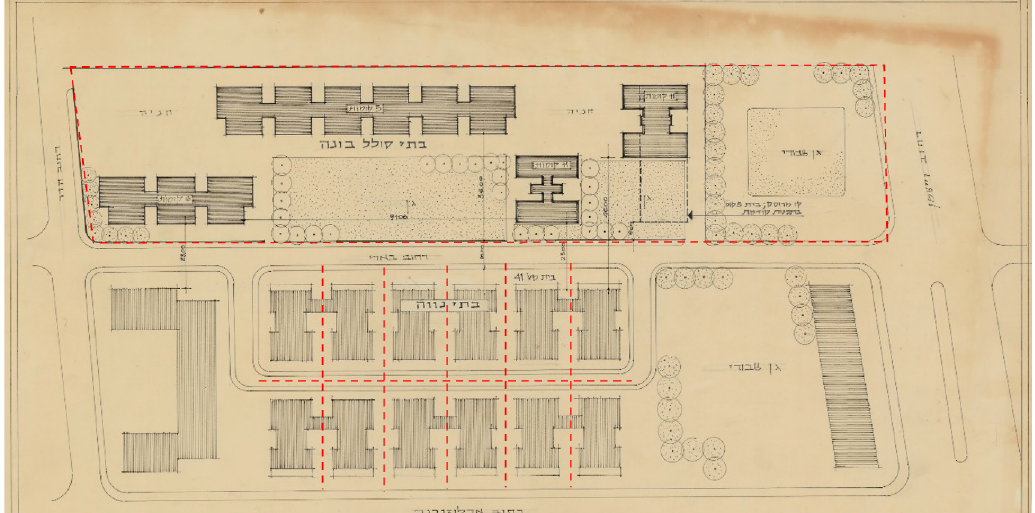
Figure 7. Schematic plan of Be’eri estate, unknown year, with graphic additions by the authors illustrating the difference between the proposed planning scheme for Be’eri estate (top) and Nave houses representing the common urban layout (bottom). Source: A. Sharon (n.d.).